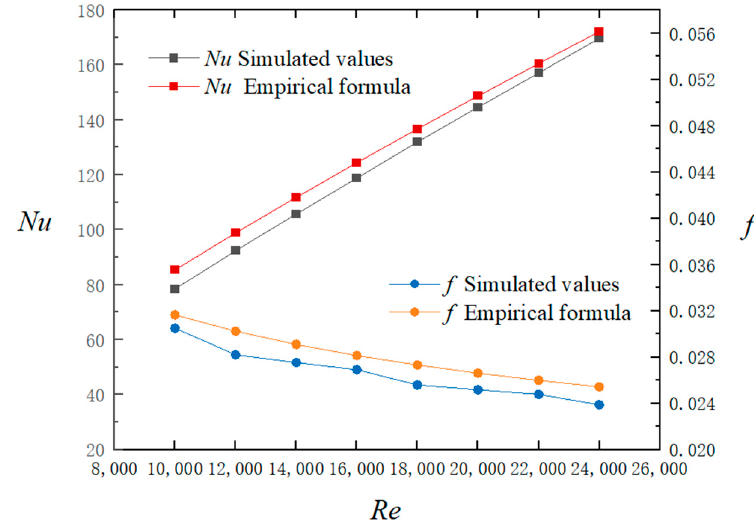
Figure 6. Verification of the numerical simulations in the straight pipe.